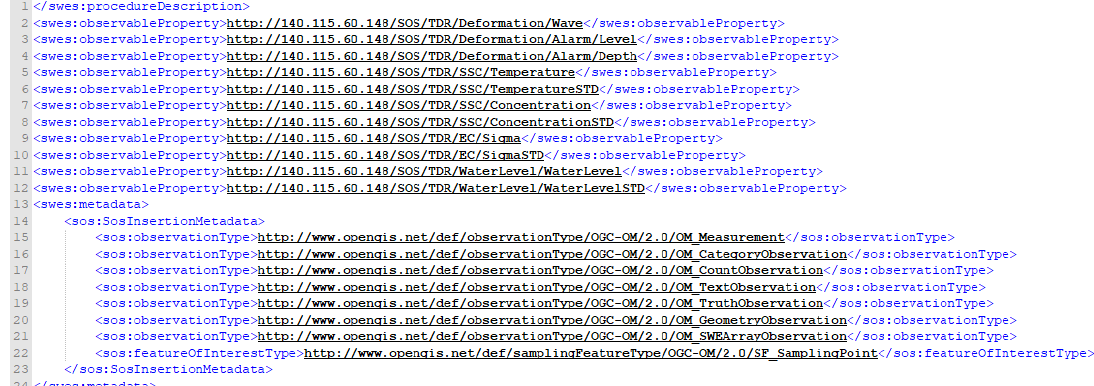
Figure 15. Insert sensor XML request of InsertSensor_observableProperty&metadata.